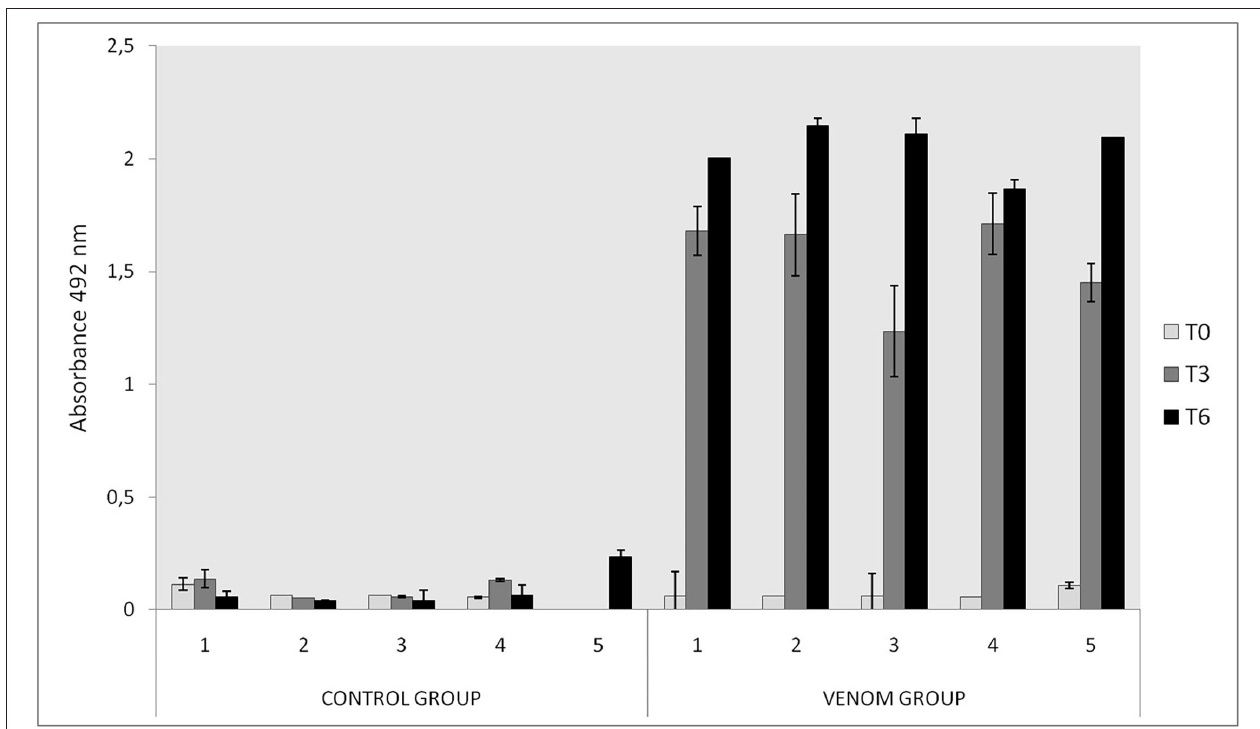
FIGURE 2 | Immunoreactivity of rabbits immunized with Loxosceles spp. venom by ELISA in T0, T3, and T6. Plates were coated with a 5 µ g/ml of each venom ( L. intermedia , L. gaucho , and L. laeta ) and sera was tested in 1/200 dilution and revealed with rabbit anti-IgG 1/5000 and o-phenylediamine dihydrochloride. The CG received Montanide and PBS and the VG received 21 µ g of Loxosceles spp. venom and Montanide. The absorbance of samples was determined at